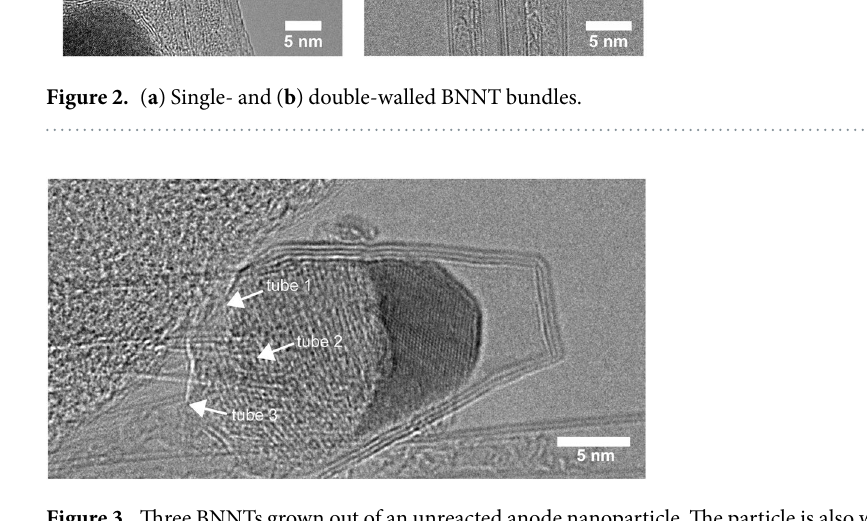
Figure 3. Three BNNTs grown out of an unreacted anode nanoparticle. The particle is also wrapped by boron nitride